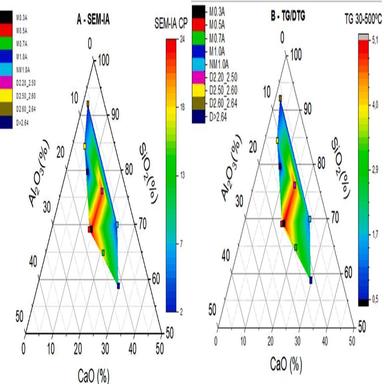
A) Sample qualification by cement paste content by SEM-IA; (B) Sample qualification by TGA dehydration/dehydroxilation step between 30 and 500º.